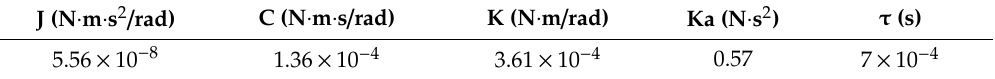
Table 4. Identified mechanism parameters used in the